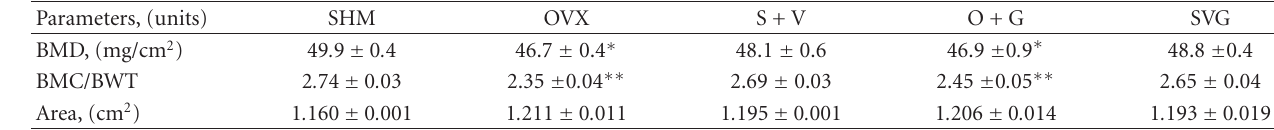
Table 1: DXA parameters of the hindlimb assessed in vivo.